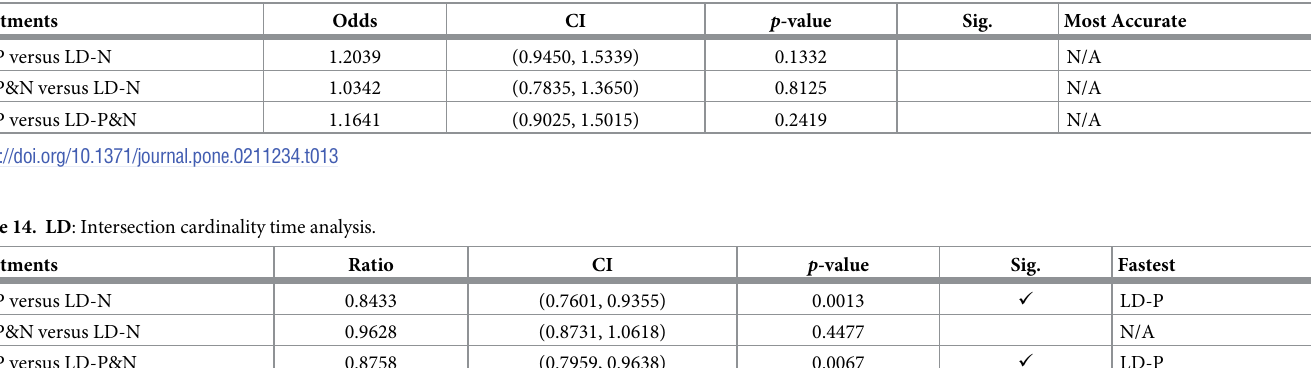
Table 13. LD : Intersection cardinality accuracy analysis.